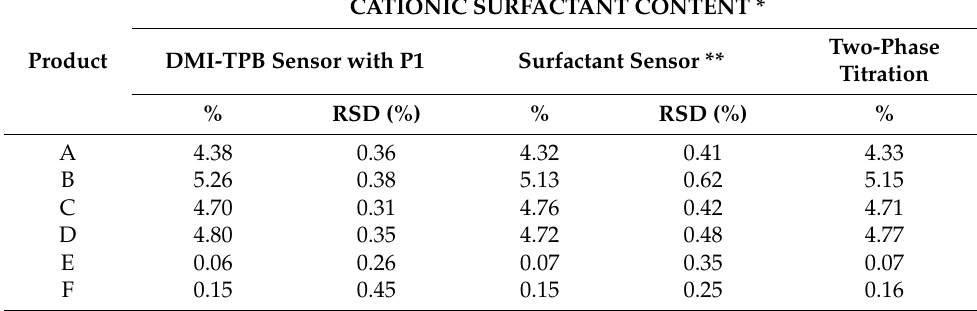
Table 8. The results of potentiometric titrations of cationic surfactants in commercial disinfectants and antiseptics samples using SDS ( c = 4 mM) as a titrant and DMI-TPB sensor containing plasticizer P5 as an indicator, in comparison with published DMI-TPB sensor containing